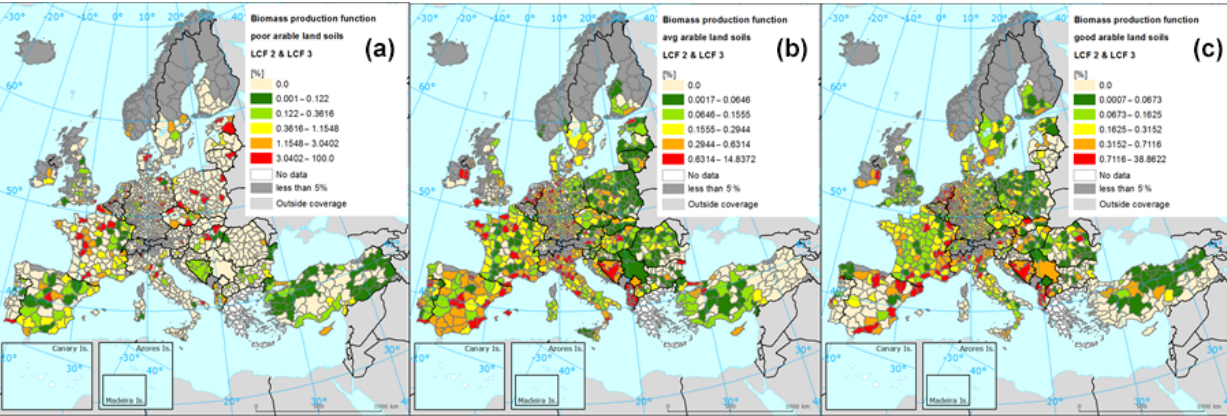
Figure 5. Percentage decline (per NUTS-3 area) of arable land area with poor (a) , average (b) , and good (c) production potentials due to urban residential, commercial, industrial, and infrastructure-related extension (LCF2 and LCF3) between 2000 and 2006. Legend shows the shares (%) from low (dark green) to high (red), “0” (light yellow), no data (white), less than 5% (dark grey), and outside data coverage (light grey). “Less than 5%” means that the total area of arable land is smaller than 5%. Note that the same colours might represent different percentages as quantiles were used during the map production. Ranges are given between 0.001 and 100% (a) , between 0.017 and 14.84% (b) , and between 0.001 and 38.86% (c)